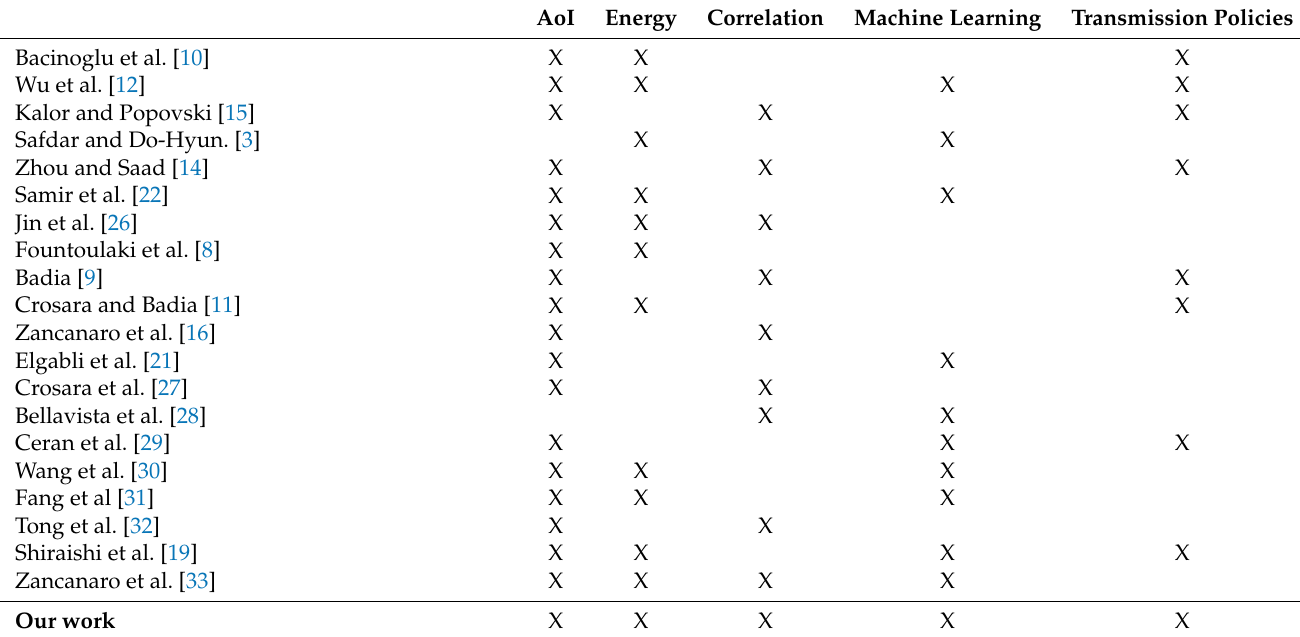
Table 1. Coverage of the topics of our paper from various studies. AoI Energy Correlation Machine Learning Transmission